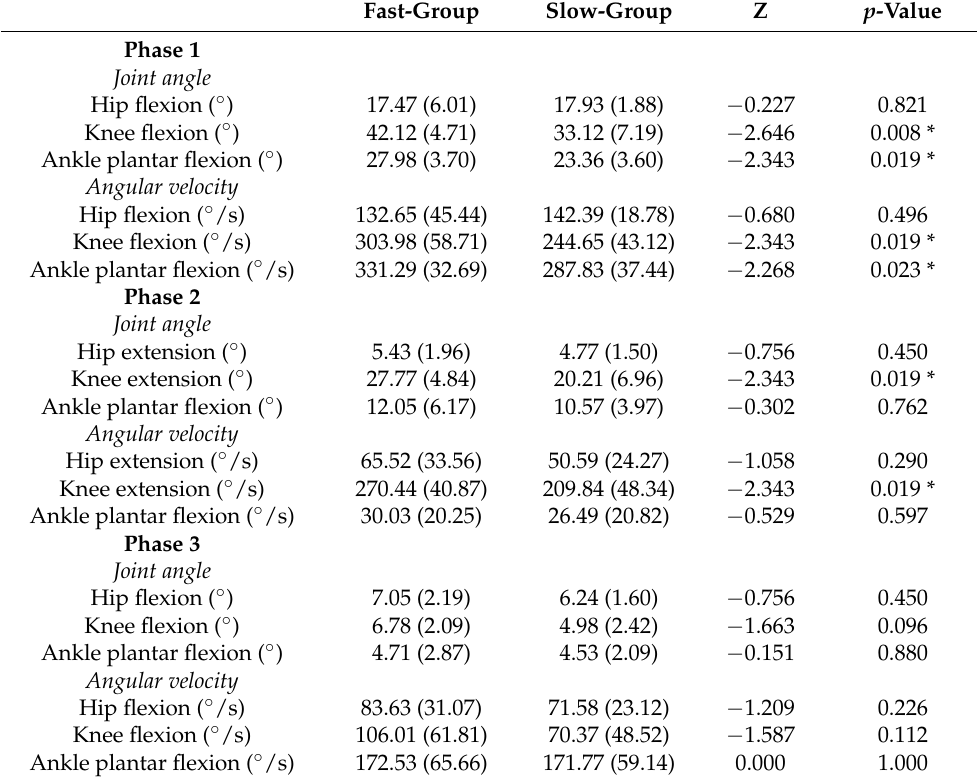
Table 2. Comparison of kinematic parameters during the unplanned gait termination in all phases between the groups.